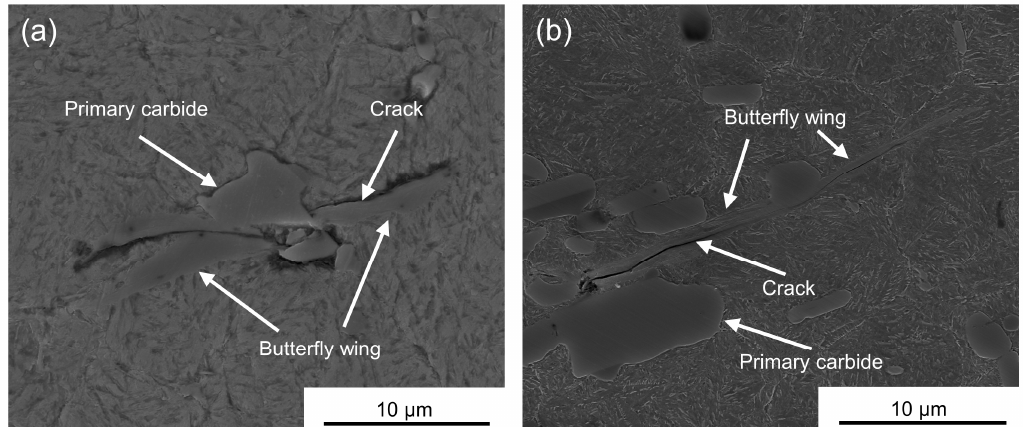
Figure 11. SEM micrographs of the butterflies in the RCF sample ( P 0 = 5 GPa, N = 5.65 × 10 8 cycles): ( a ) SEM micrograph of a butterfly initiated at a cracked primary carbide; ( b ) SEM micrograph of a butterfly with cracks.